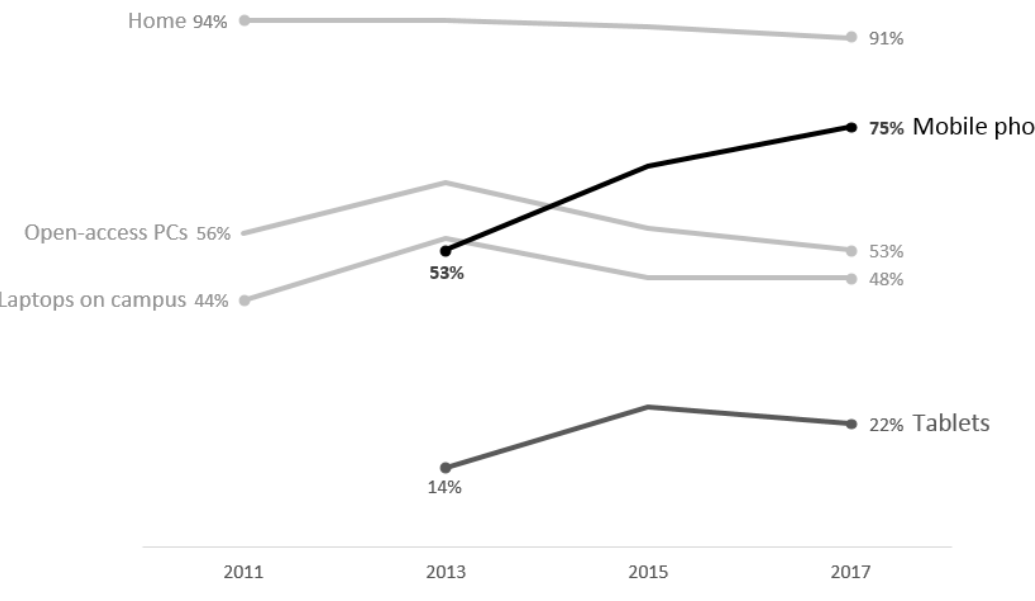
Figure 2: Substantial growth in mobile phone access to the VLE (note in 2011, there was 16% access from mobile devices).